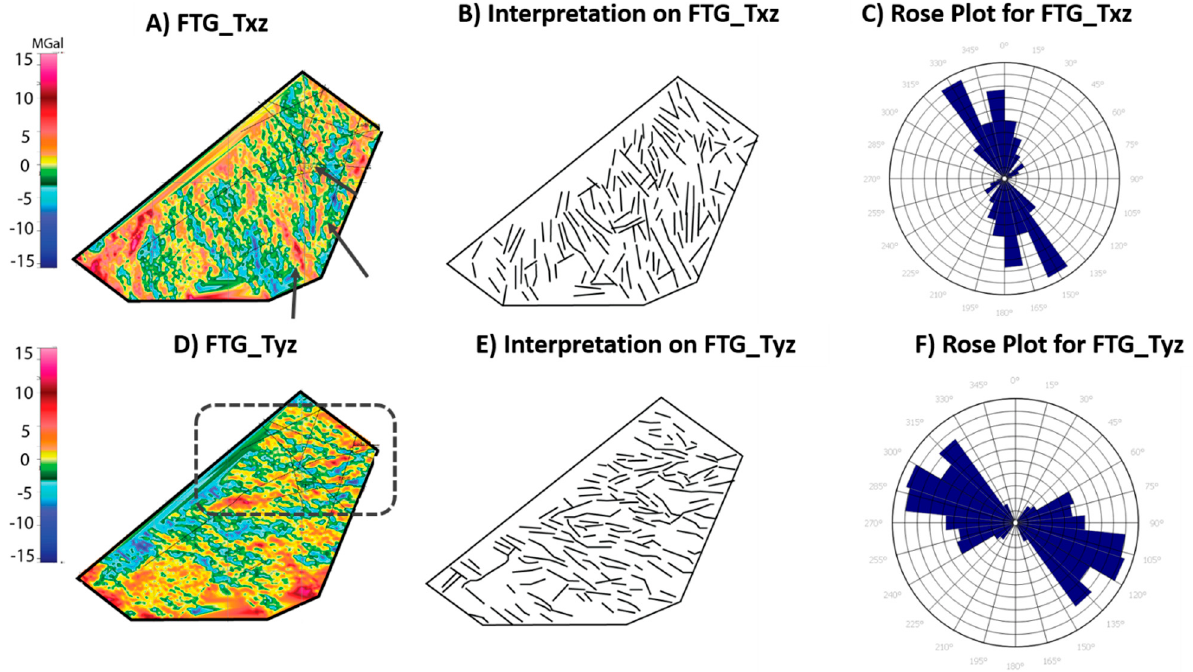
Figure 9. ( A ) Anomaly map of FTG_Txz domain; ( B ) Interpretation of structural trend on FTG_Txz data; ( C ) Rose plot diagram of interpreted structural trends for FTG_Txz showing NNW-SSE orientation. ( D ) Anomaly map of FTG_Tyz domain; ( E ) Interpretation of structural trend on FTG_Txz data; ( F ) Rose plot diagram of interpreted structural trends for FTG_Tyz showing NW-SE to E-W orientations.